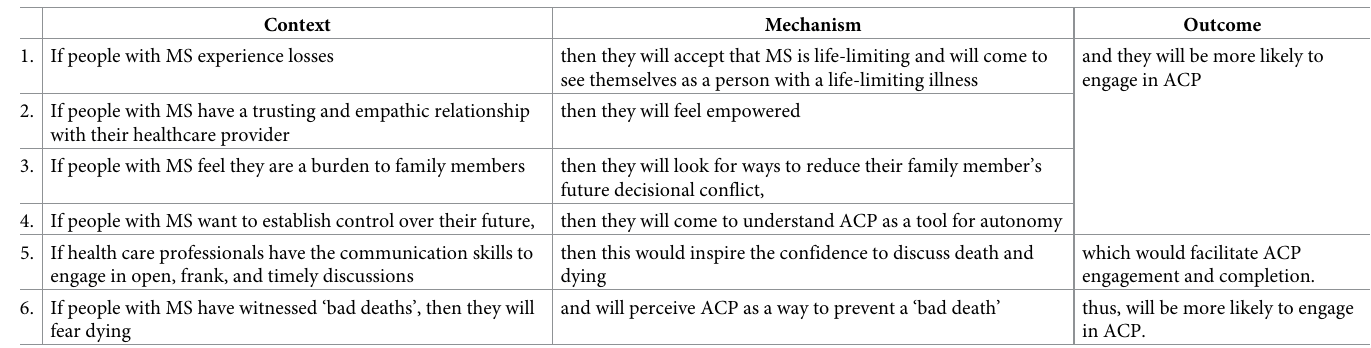
Table 1. ‘Context-mechanism-outcome’ hypotheses